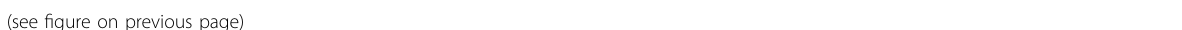
Fig. 3 AR directs transcriptional activation of EHF in PCa. A ChIP-Seq pro fi les in androgen-stimulated LNCaP cells (GSE55007) indicating AR enrichment on four genomic sites (peaks 1 – 4) located in the EHF ’ s fi rst intron region. B Schema showing AR-binding motif obtained from the JASPAR database (top). Bottom panel showing two putative direct AR-binding sites selected from the DNA sequences represented by peaks 1 – 4. C ChIP- qPCR data showing recruitment of AR on the EHF ’ s fi rst intron upon R1881 (10 nM) stimulation in LNCaP cells. D Same condition as in C , except H3K9Ac marks on the EHF ’ s fi rst intron. E ChIP-qPCR data indicating enrichment of AR on the EHF ’ s fi rst intron in R1881 (10 nM)-stimulated C4-2 cells with/without ENZ treatment (10 μ M). PSA (KLK3) promoter was employed as a positive control for R1881 or ENZ treatment ( C , D ). F Transcriptional activation ability of ARE1 and ARE2 as indicated by increased luciferase reporter activity. Luminescence units were normalized by Renilla luciferase signal. G Transcriptional inhibitory function of ARE mutants (sequences are presented) was indicated by dual-luciferase reporter assay. Nucleotides in red are sequences of consensus ARE1, mutated ARE1, and deleted ARE1, respectively. The two-tailed Student ’ s t test or one-way ANOVA, followed by Dunnett ’ s t test was used to compare results between two groups. Experiments were performed with three biologically independent samples. Bar graphs show means ± SD. ARE androgen-responsive element, H3K9Ac H3 lysine 9